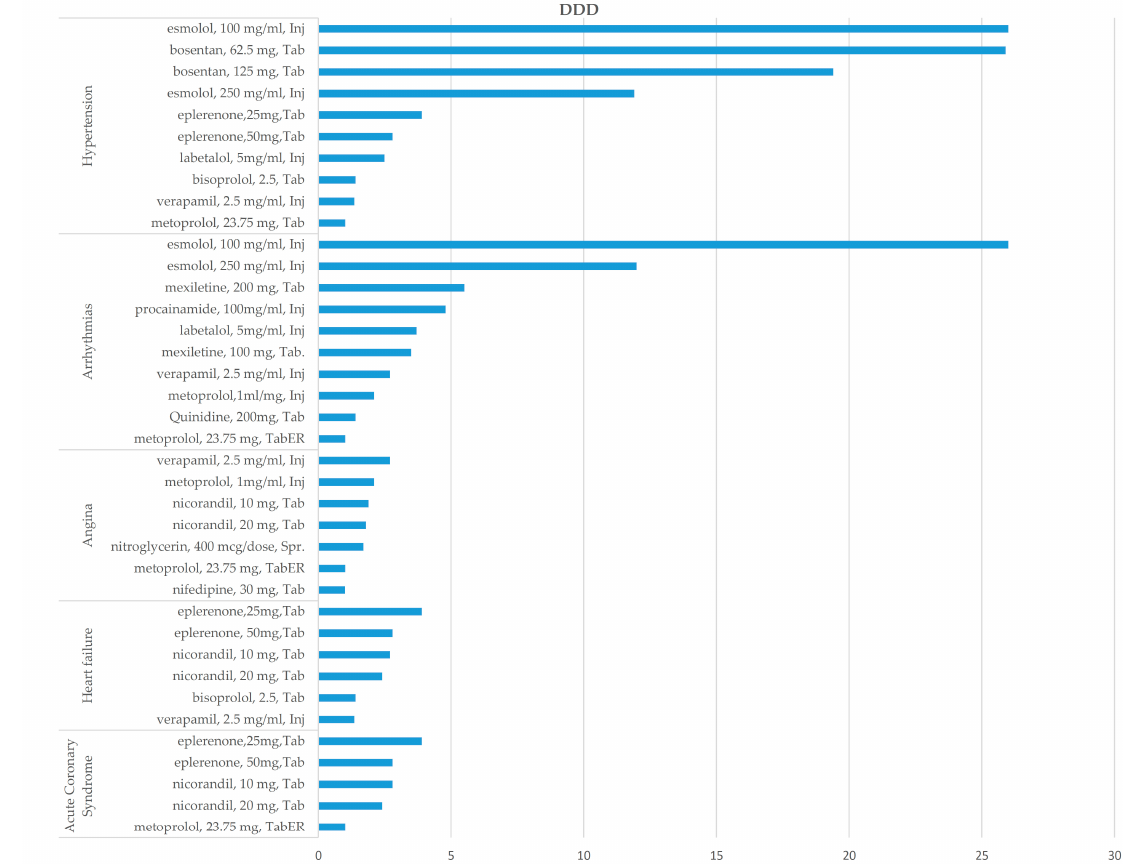
Figure 2. The non-affordable medicines in the minimum prescribed daily dose (PDD) scenario. Figure 2. The non-a ff ordable medicines in the minimum prescribed daily dose (PDD) scenario. Int. J. Environ. Res. Public Health 2020 , 17 , x FOR PEER REVIEW